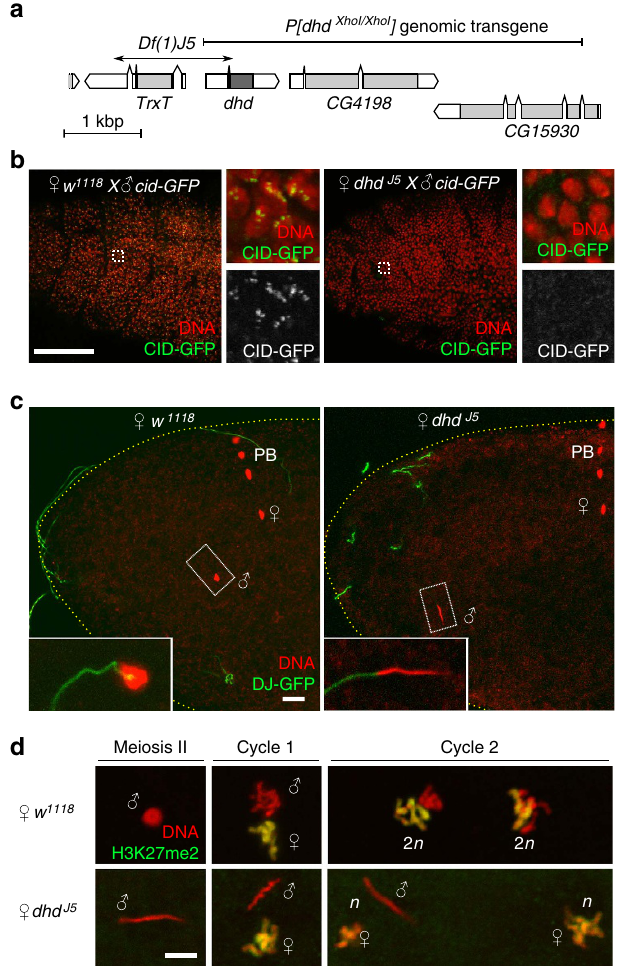
Figure 1 | DHD is required for sperm nuclear decondensation. ( a ) The dhd genomic region (4F4, X chromosome) showing the genomic P[dhd XhoI/XhoI ] rescue transgene and the Df(1)J5 deletion that disrupts dhd and TrxT . ( b ) Zygotic expression of the paternally-inherited cid-GFP transgene, which expresses a GFP-tagged centromeric histone (insets), is detected in late control embryos but not in dhd embryos. Scale bar, 50 m m. ( c ) At fertilization, the sperm nucleus (inset) fails to decondense in dhd eggs. The sperm flagellum is stained with the Don Juan(DJ)-GFP marker (green). DNA is in red. Note that the four female meiotic products are visible in both eggs. Scale bar, 10 m m. ( d ) The sperm nucleus does not participate in the early zygotic mitoses in dhd embryos. Maternal chromosomes are visualized with anti-H3K27me2 staining (green) and appear yellow. PB: polar bodies. Scale bar, 5 m